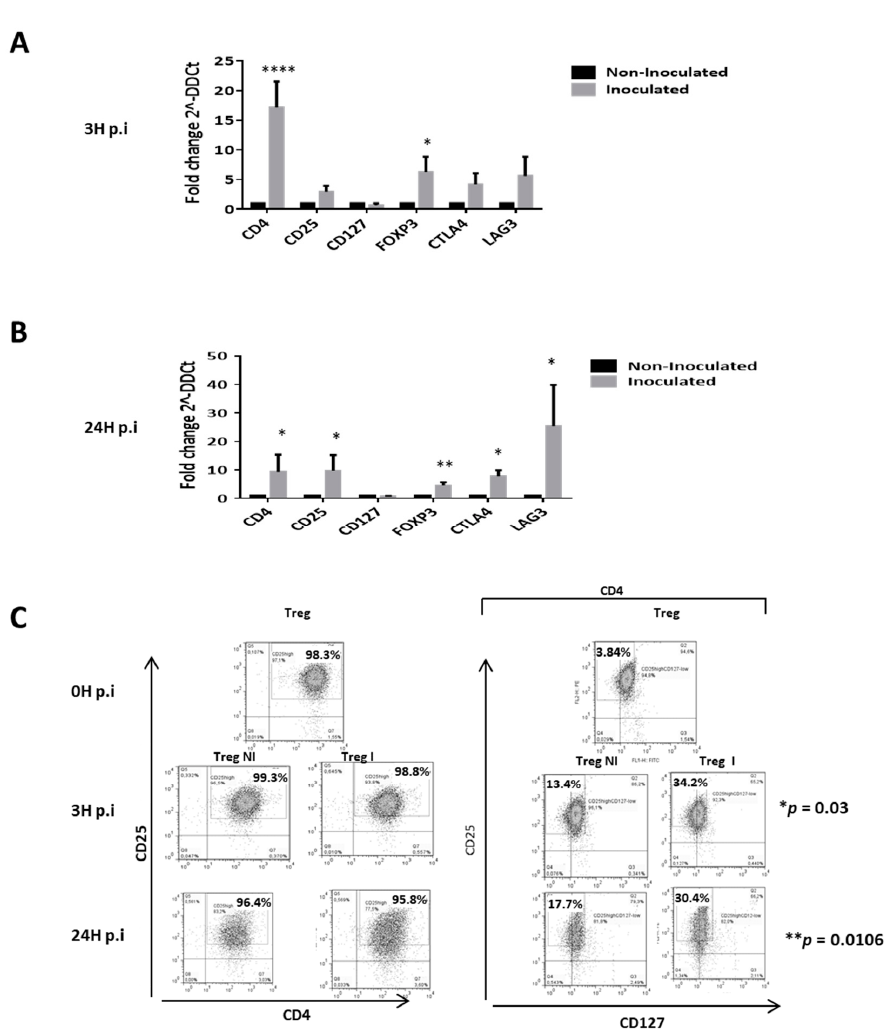
Figure 3. HCV inoculation increases the suppressive phenotype of Tregs. HCV inoculation affects CD4, CD25, CD127, FOXP3, CTLA4 and LAG3 expression in activated Tregs at 3 hours post HCV inoculation (3 h p.i) ( A ) and 24 h p.i ( B ) . Results are presented as means of four independent experiments of inoculated Tregs ( light grey bars ) versus non-inoculated Tregs (dark bars). Gene expressions are normalized by using GADPH, beta-actin, 18s and HRPT mRNA as housekeeping-genes and result are expressed in fold change (2 – ΔΔ Ct ) ± SEM bars. ( C ) Representative dot plot of double stained CD4+CD25 high and CD25 high CD127 -/low Tregs 0 h post HCV inoculation (0 h p.i), 3 h p.i and 24 h p.i.